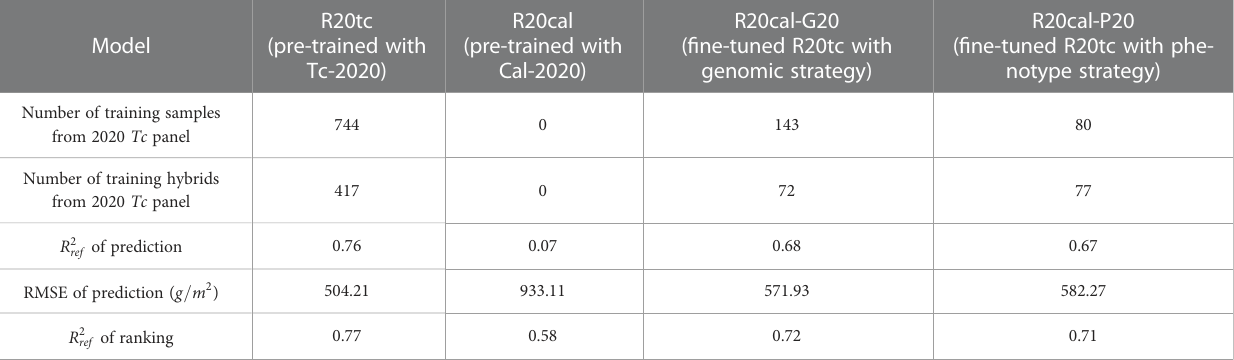
TABLE 4 Biomass prediction results obtained by the 4 models on the Tc and Cal panels in 2020. Model